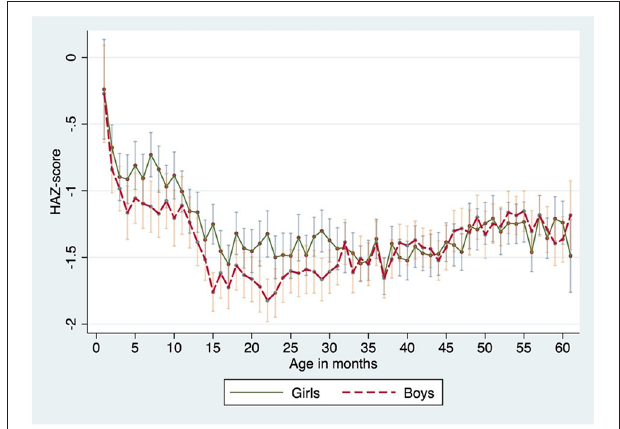
FIGURE 2 | HAZ-Score densities 2017–2019. Source: Own elaboration based on Caritas Venezuela data.